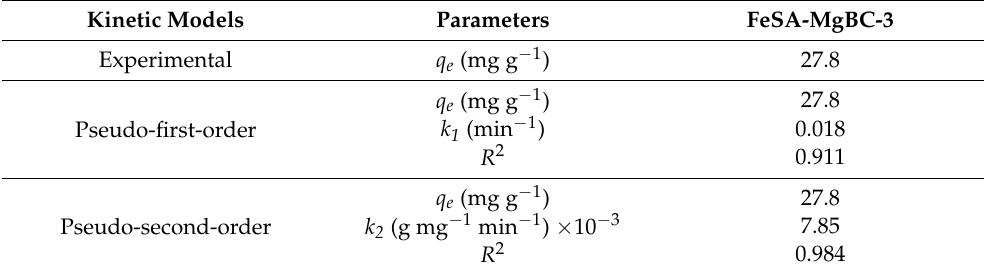
Figure 4. Adsorption ( a ) kinetics, ( b ) isotherms, and ( c ) thermodynamics of PO 4 -P on FeSA-MgBC-3. Table 2. Kinetic adsorption parameters in this